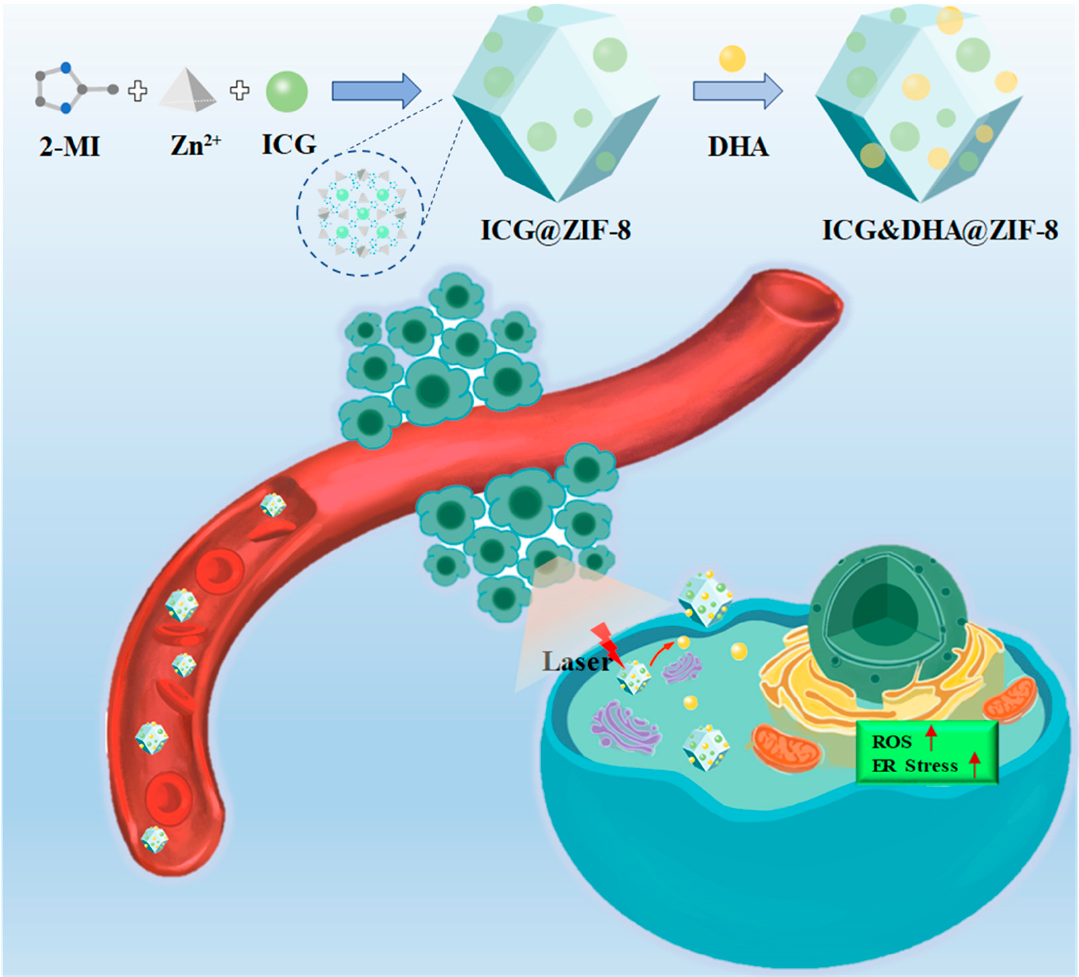
Scheme 1. The schematic illustration of ICG&DHA@ZIF-8 nanoparticles mediated co-delivery of antitumor agent DHA and photosensitizer ICG. 2-MI: 2-nitroimidazole, ICG: indocyanine green. Upward arrow ( ↑ ) represents up-regulation of ROS level or ER